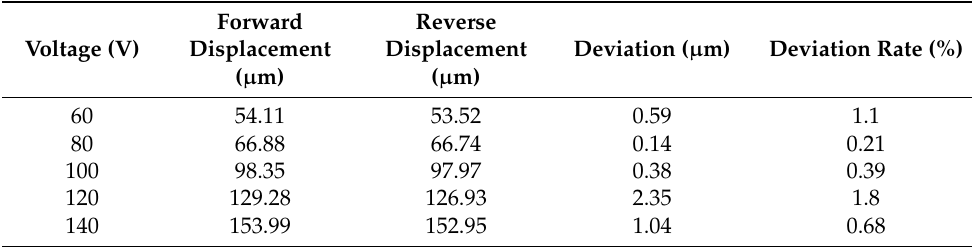
Figure 9. ( a ) The forward and reverse cumulative displacements of the improved actuator in 40 steps obtained under the fixed driving frequency of 10 Hz and various driving voltages, and ( b ) the corresponding speed changing with the driving voltage. Table 2. The detailed forward and reverse displacements of 40 steps obtained under various driving voltages, as well as the deviation analysis.